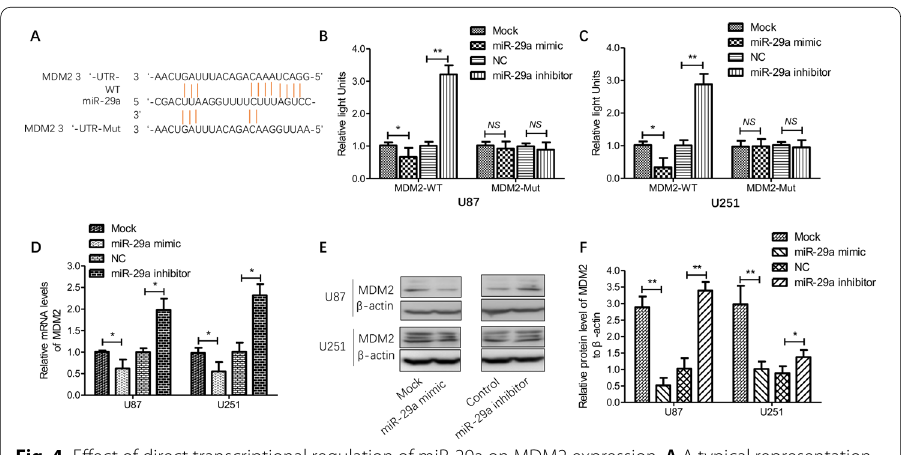
Fig. 4 Effect of direct transcriptional regulation of miR-29a on MDM2 expression. A A typical representation of the putative binding site of miR-29a in the 3 ʹ -UTR of MDM2. B , C Firstly, the wild-type or mutated full-length 3 ʹ -UTR of the MDM2 gene was cloned into dual-luciferase reporter vectors; secondly, the vectors were co-transfected with miR-29a mimics, inhibitors or corresponding controls; finally, the activity was evaluated by luciferase reporter assay. D In glioma cells with miR-29a mimic, inhibitor or corresponding control transfection, relative mRNA levels of MDM2 were measured by relative quantity RT-PCR. E – F In glioma cells mentioned above, protein levels of MDM2 were detected by western blotting. Results are expressed as the mean SD (n 3). *P < 0.05; **P < ± =